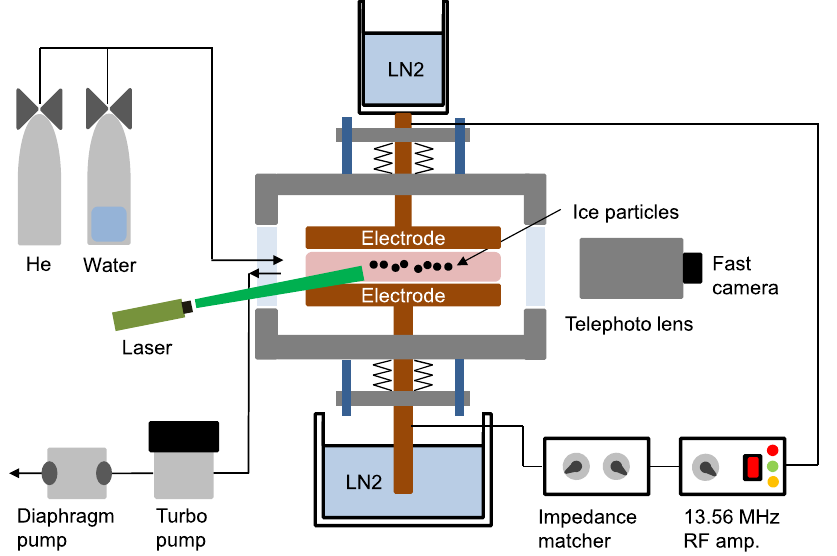
Figure 1. Sketch of our laboratory apparatus. Plasmas are obtained between two parallel electrodes made of copper and connected to liquid nitrogen cooling systems. A 13.56 MHz RF is used to ignite the plasma with helium gas. In order to trace ice particle motions, a green laser sheet is illuminated to the particles formed and levitating in a plasma and then scattered images from the particles are recorded by a CMOS camera at 300 fps. It is noticeable that the temperature of the upper electrode is always cooler than that of the bottom electrode probably due to the better thermal contact of the upper electrode cooling system. Thus, thermophoretic force acts on the ice particles upwards while the gravitational force is exerted